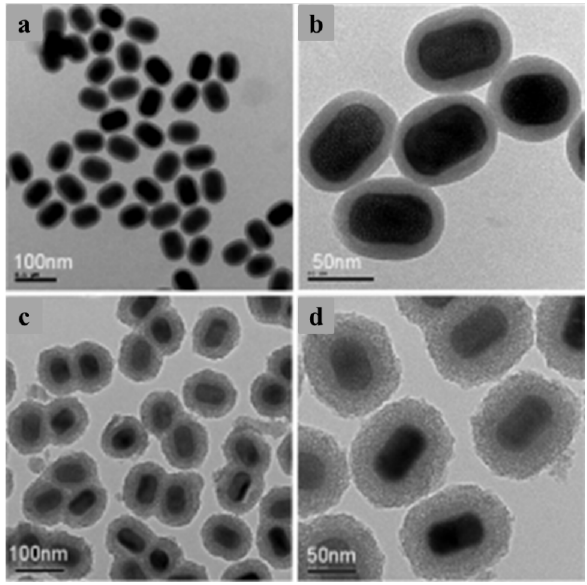
Figure 7: a,b) TEM images of NaYF 4 :Yb/Er@silica nanoparticles. c,d) mesoporous-silica-coated NaYF 4 :Yb/Er@silica nanoparticles